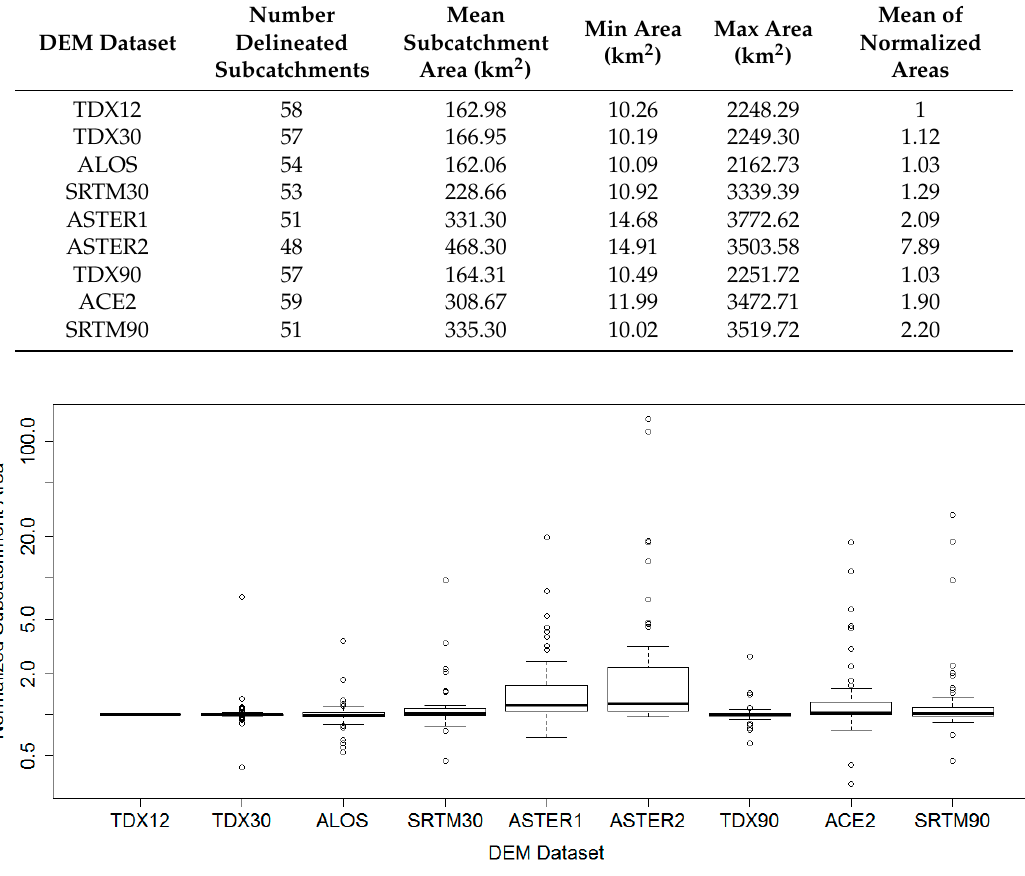
Figure 6. Subcatchment areas normalized to their matching TDX12 subcatchments, with logarithmic scale on the y -axis, grouped by DEM dataset. The TDX30, TDX90, and ALOS datasets have similar median values and relatively tight quartile values, with SRTM30 and SRTM90 datasets following closely, then ACE2, and lastly with the ASTER1 and ASTER2 datasets having a much larger set of subcatchment areas compared to their matching TDX12 subcatchments.